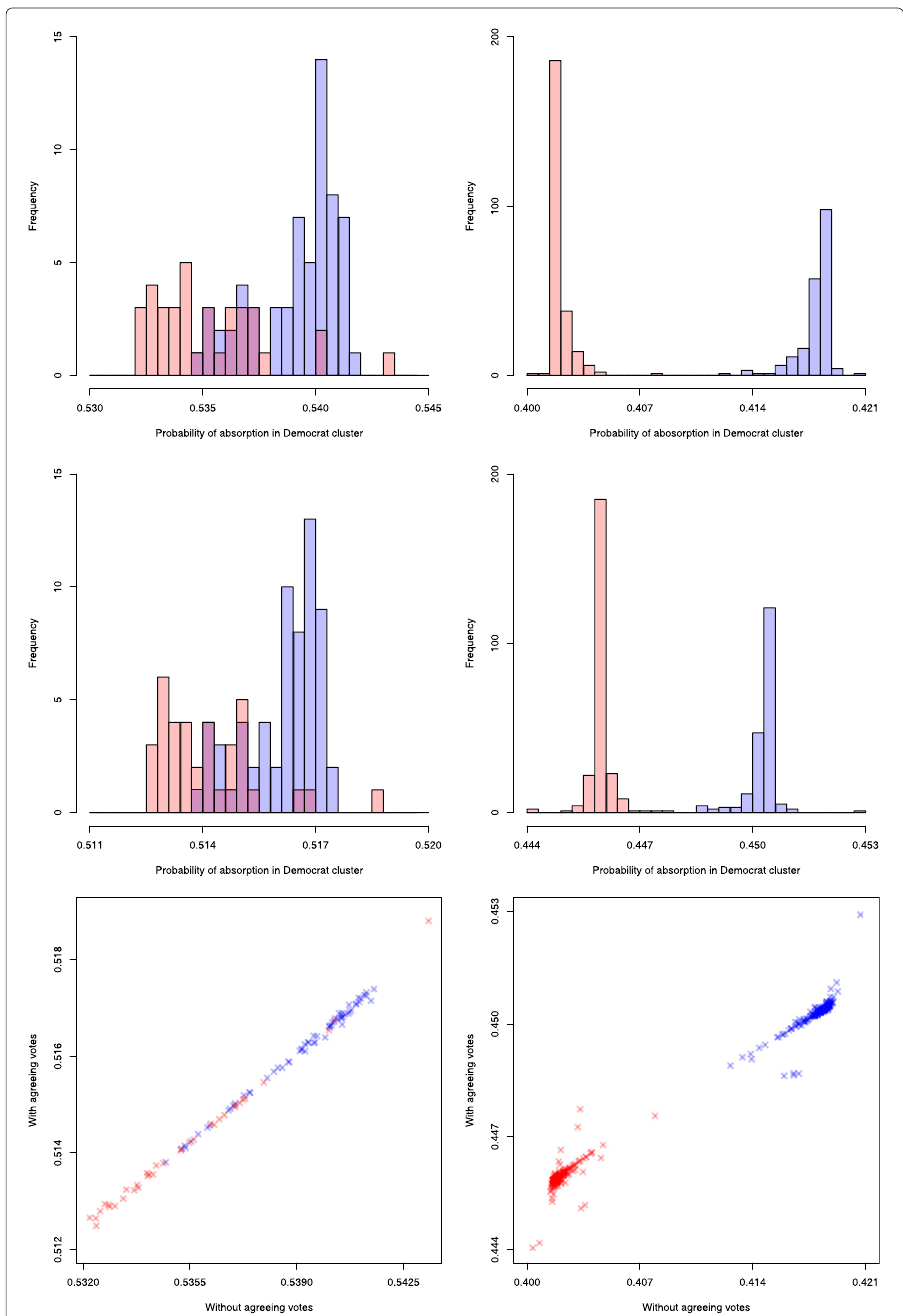
Fig. 4 Clockwise from top right: histogram of absorption probabilities for the 115 th House, without agreeing votes; histogram of absorption probabilities for the 115 th House, with agreeing votes; scatterplot of absorption probabilities for the 115 th House; scatterplot of absorption probabilities for the 90 th Senate; histogram of absorption probabilities for the 90 th Senate, with agreeing votes; histogram of absorption probabilities for the 90 th Senate, without agreeing votes. In the histograms, red bars represent Republicans and blue bars represent Democrats. In the scatterplots, red crosses represent Republicans and blue crosses represent Democrats. The 90 th Senate and 115 th House represent the least partisan and most partisan roll call voting networks analysed, respectively. For a detailed interpretation of these plots, see Sensitivity